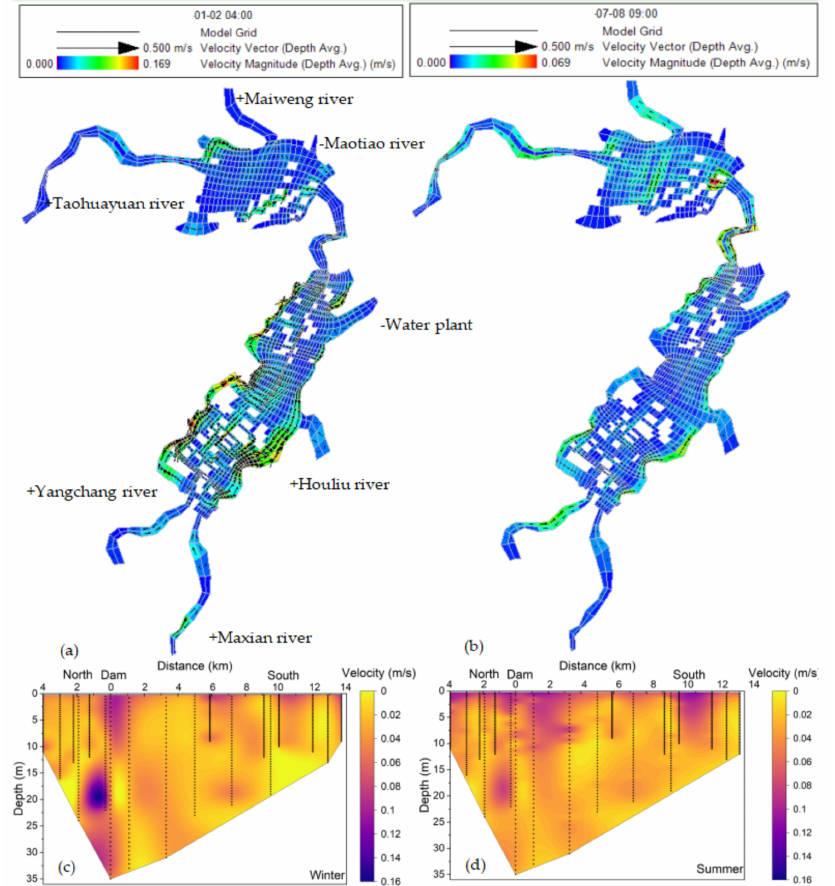
Figure 5. Flow field in winter ( a ) and summer ( b ); average velocity of the vertical profile in winter ( c ) and summer ( d ) simulated by EFDC. The arrow represents the direction of flow, + means input river, − means the output of the